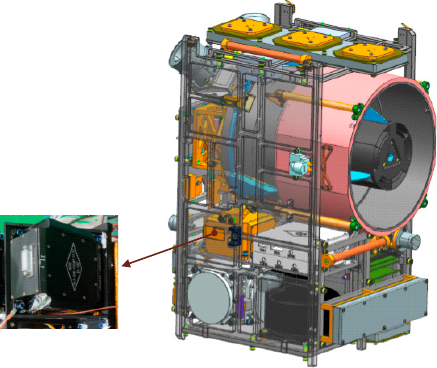
Figure 20. Three-axis gyro within the satellite.